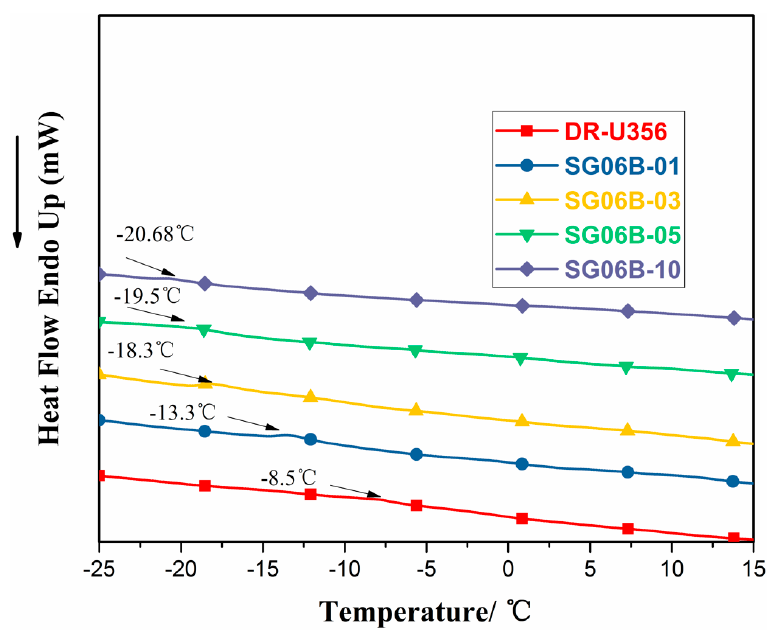
Figure 11. Differential scanning calorimetry (DSC) curves of different contents of SG06B graft UV-cured resin.